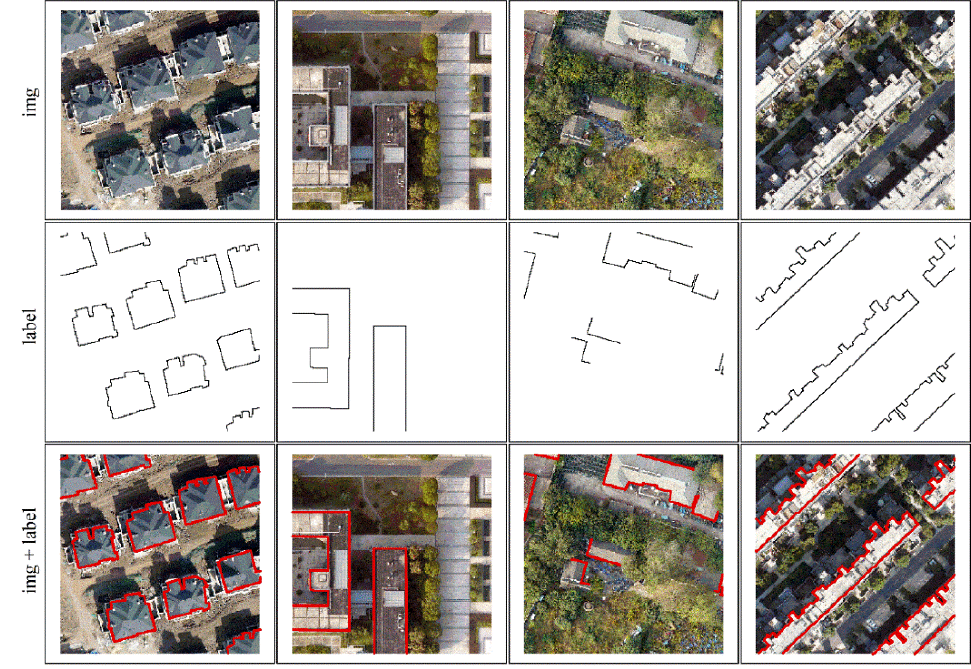
Figure 3. The sample of Nanjing dataset.